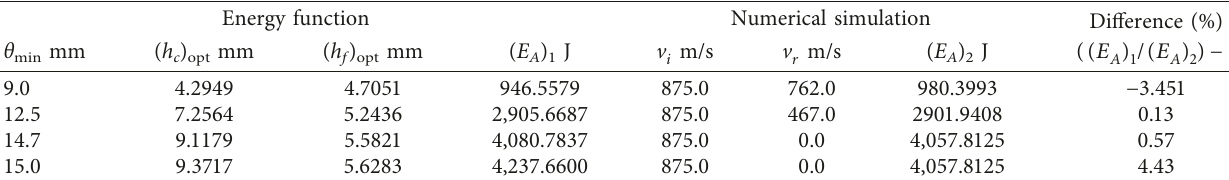
Figure 7: Optimal thickness combination of the composite materials. Table 9: Verification of the energy function.